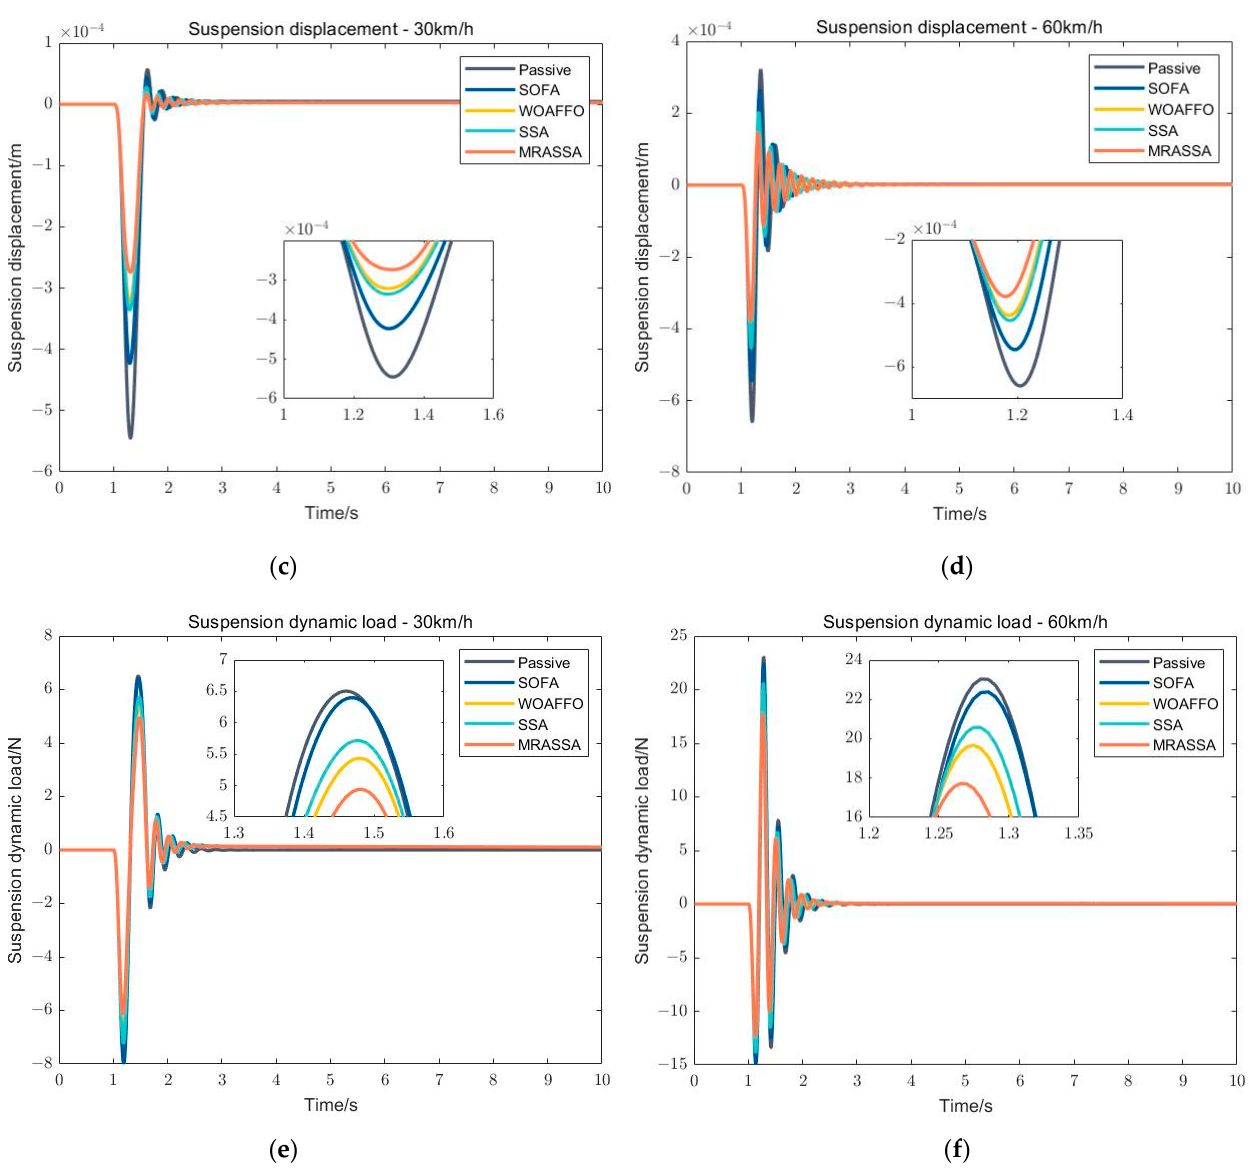
Figure 9. Suspension performance at the single bump in the simulation. ( a ) Suspension acceleration at 30 km/h; ( b ) Suspension acceleration at 60 km/h; ( c ) Suspension displacement at 30 km/h; ( d ) Suspension displacement at 60 km/h; ( e ) Suspension dynamic load at 30 km/h; ( f ) Suspension dynamic load at 60 km/h.